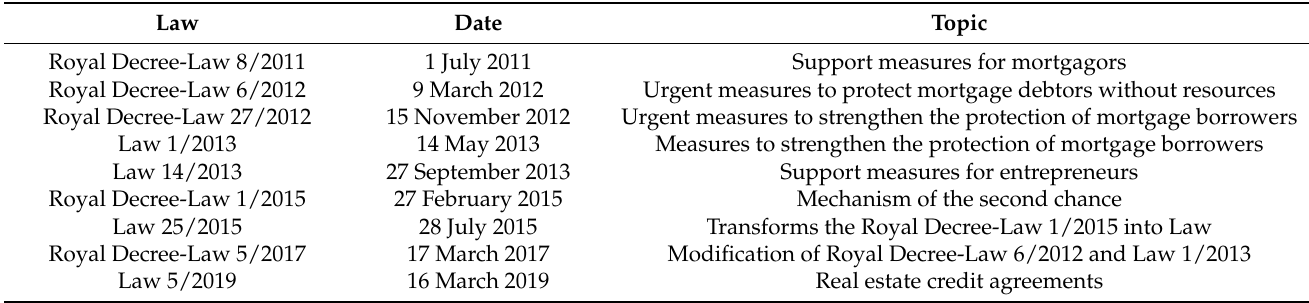
Table 6. Laws approved in the sample